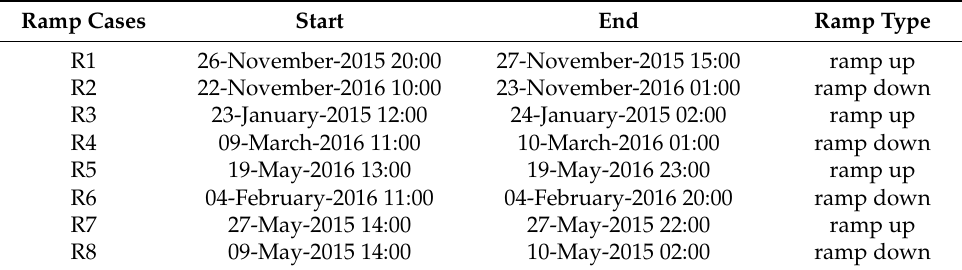
Table 1. Case study ramp start and end times (to the nearest hour) and type of ramp. Ramp